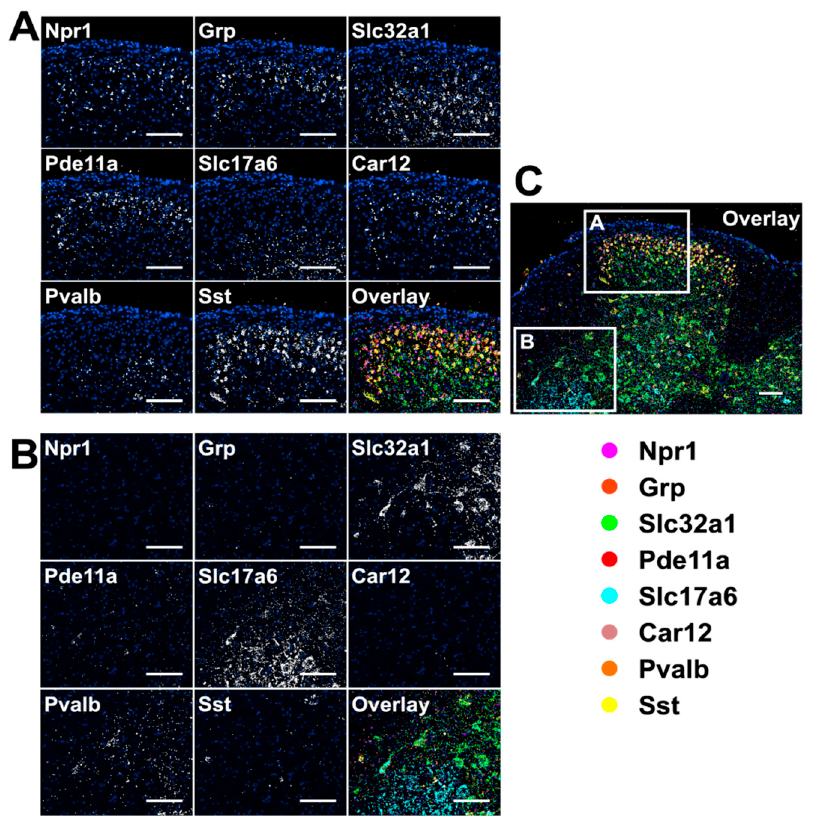
Figure 5. Eight different mRNA in a fixed frozen mouse spinal cord tissue are stained sequentially with tyramide-N 3 -Cy5. ( A , B ) are the different regions of the overlay image ( C ). Scale bar, 100 µm.